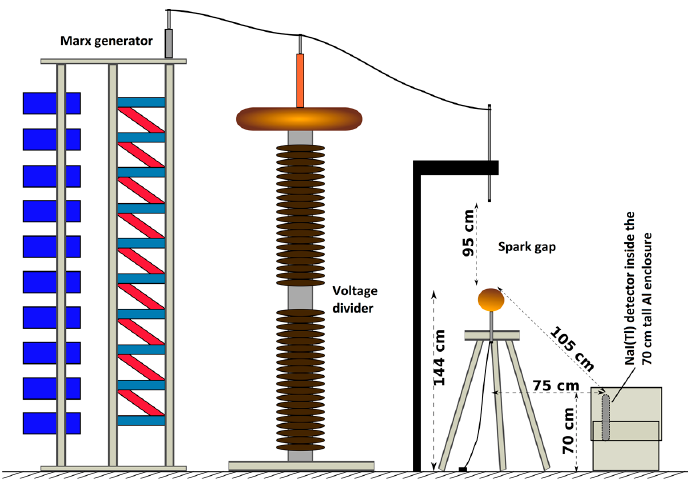
Figure 1. The experimental setup consisting of the Marx generator, voltage divider, spark gap and the X-ray detector (seen from left to right, not in real